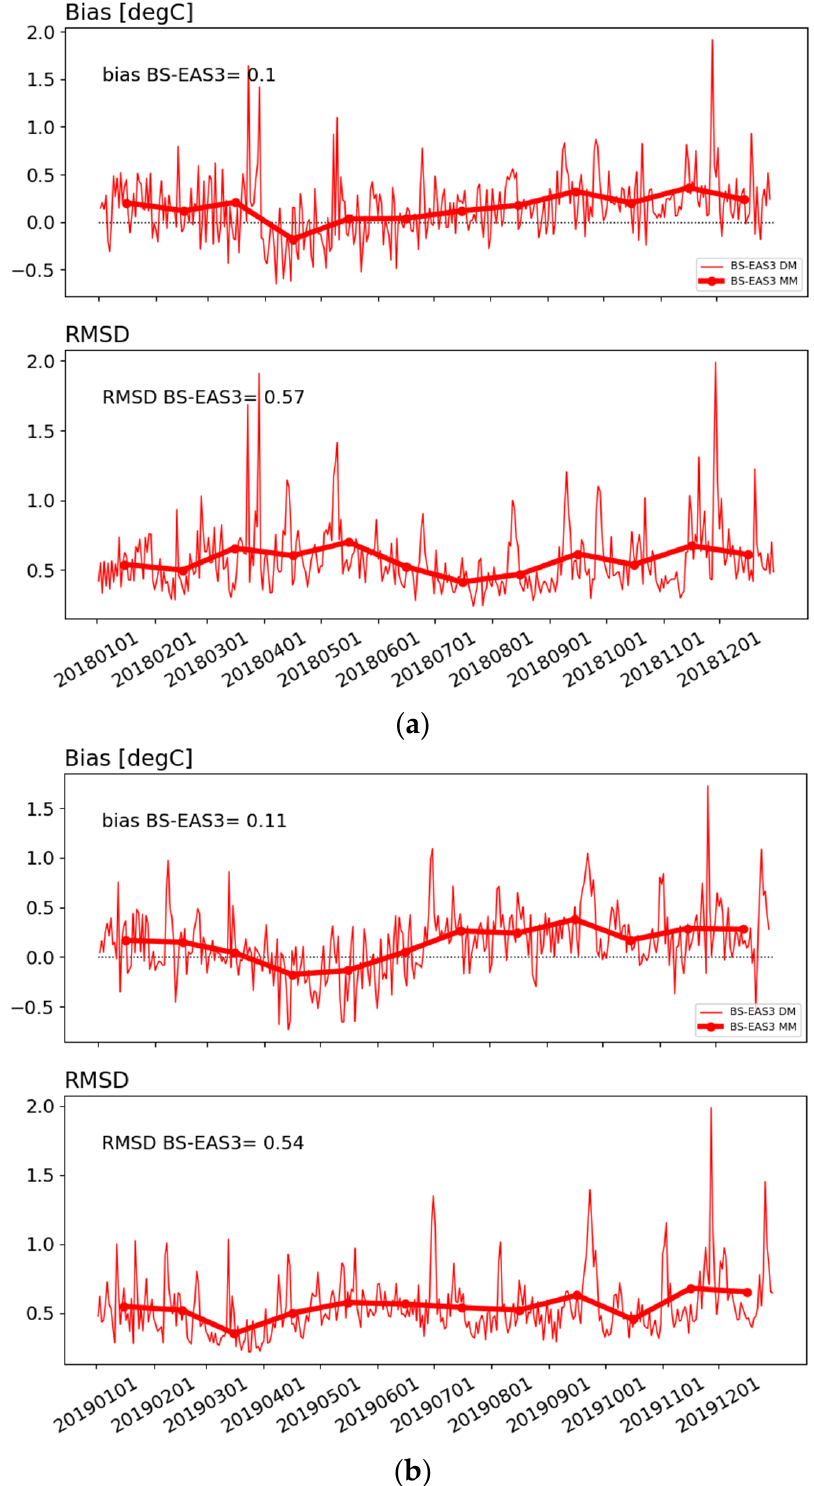
Figure 3. SST bias (top) and RMSE (bottom) timeseries, expressed in °C, at daily (thinner line) and monthly (solid line) frequency in 2018 ( a ) and 2019 ( b ).